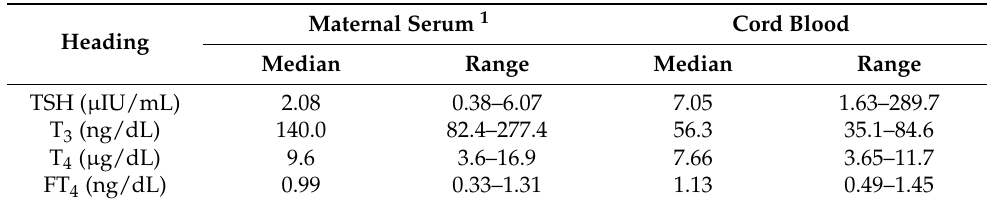
Table 3. Concentrations of thyroid hormones in maternal serum and cord blood before delivery ( n =